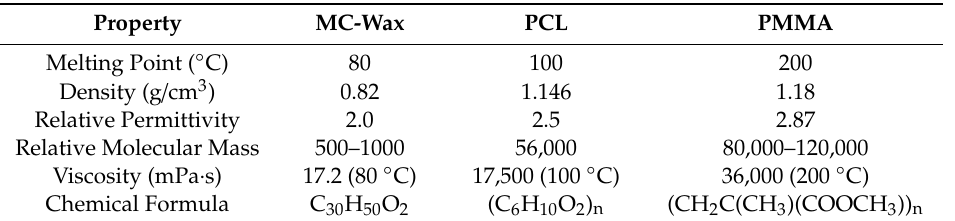
Table 1. Polymer parameters for EFD µ -3D printing.